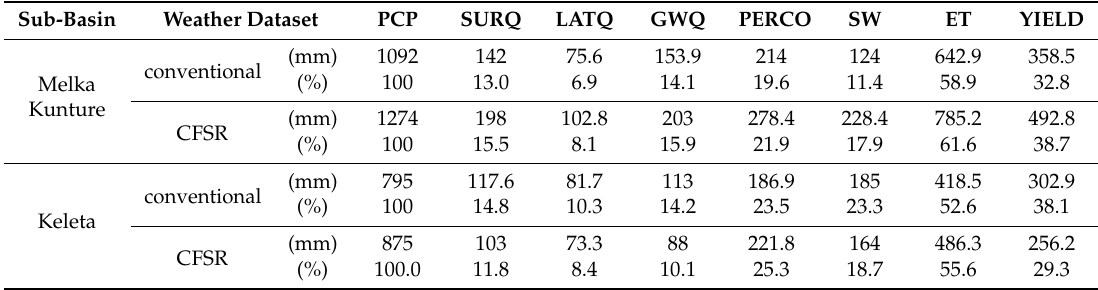
Table 4. Water balance component simulated using the two weather